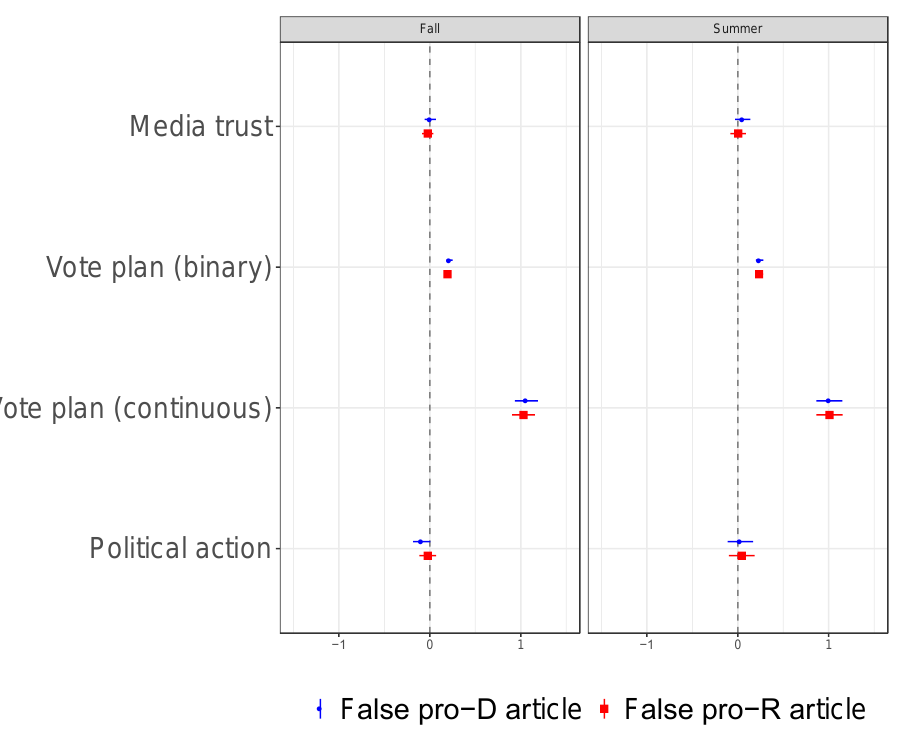
Figure 4b. Effect of false article exposure on attitudes and participation intentions: Media trust and political participation. Effect of exposure to a false article from an untrustworthy website on media trust, vote intentions, and willingness to take political action. Point estimates (with 95% confidence intervals) from separate OLS regressions. Outcome measures are a four- point scale of self- reported trust and confidence in the mass media ranging from “None at all” (1) to “A great deal” (4); whether respondents say they are “absolutely certain” to vote or report already having voted (0/1); a five -point measure of vote intention ranging from answering no when asked if they plan to vote (1) to saying they are “absolutely certain” to v ote or report already having voted (5); and respondents’ average response when asked if they would be willing to take a series of political actions on a scale from “Disagree strongly” (1) to “Agree strongly” (5). Control variables include partisanship, ide ology, political knowledge, feelings toward President Trump, age, race, and college education. See Table B7 for full